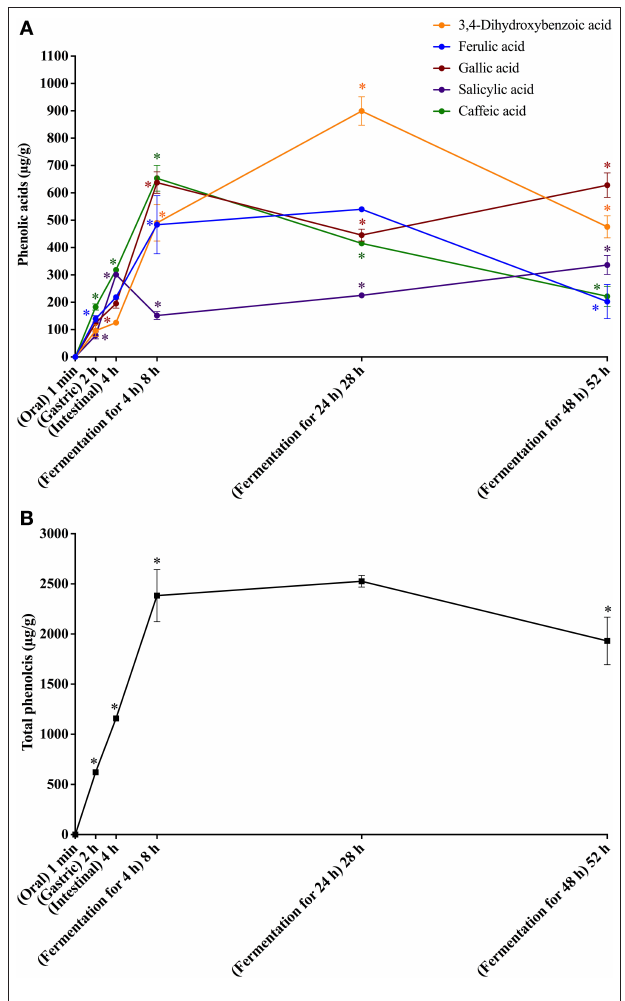
FIGURE 3 | In vitro simulated digestion (oral, gastric and intestinal steps) and gut fermentation of coffee melanoidin-bound phenolic compounds: phenolic acids (A) and total phenolics (B) . The asterisk indicates a significant difference in relation to the previous step (ANOVA followed by Tukey’s post-test, p <